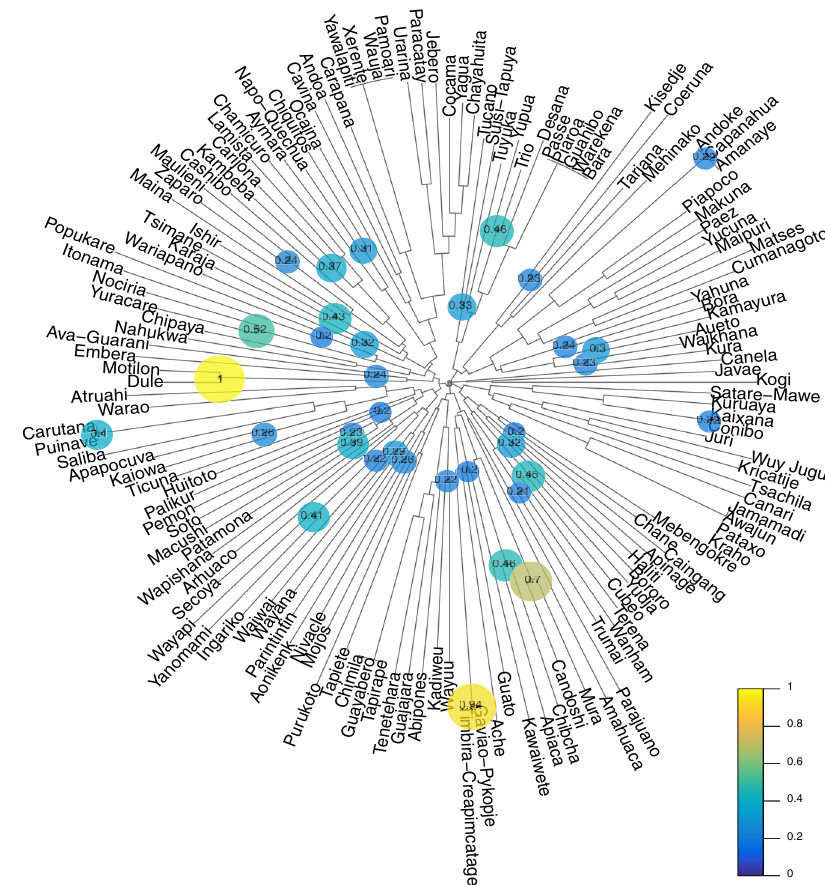
Fig. 5 A Neighbour-Joining tree representing the distances between societies according to their sets of instruments. Bootstrap values are indicated as the proportion of times that the same node is reconstructed over 1000 iterations: large, light-coloured dots correspond to high bootstrap values (nodes robustly reconstructed). Only bootstrap values above 0.2 are